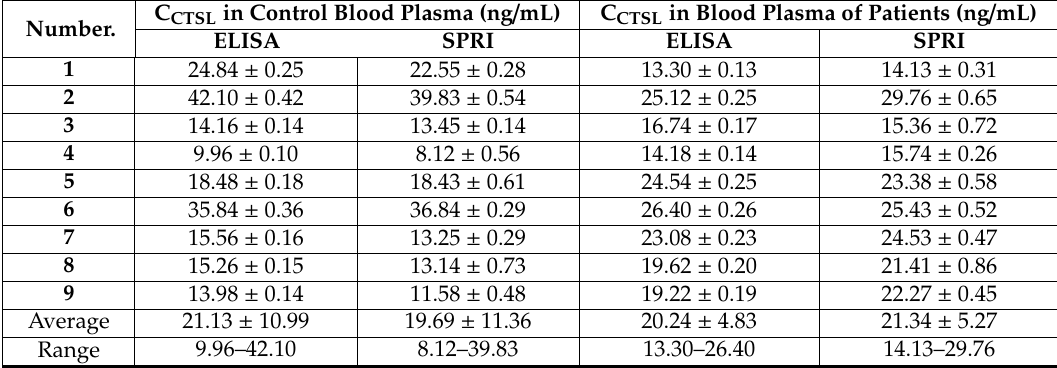
Table 3. The Cathepsin-L (CTSL) concentration in the di ff erent types of the human blood plasma determined by the Surface Plasmon Resonance Imaging (SPRI) biosensor and ELISA.